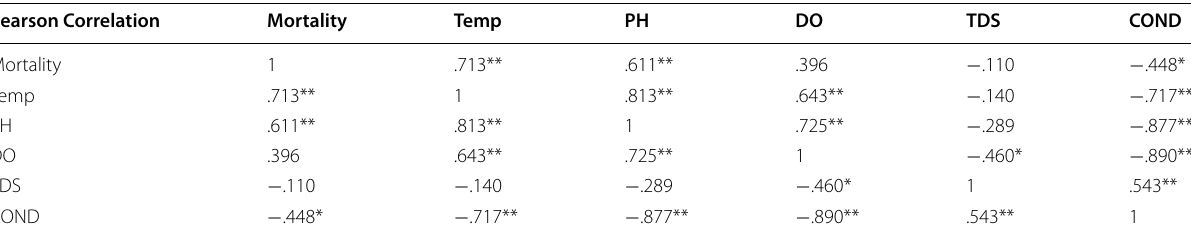
Table 4 Correlations of mean mortality values and mean values of physicochemical parameters of ethanolic leaf extract of Allium sativum